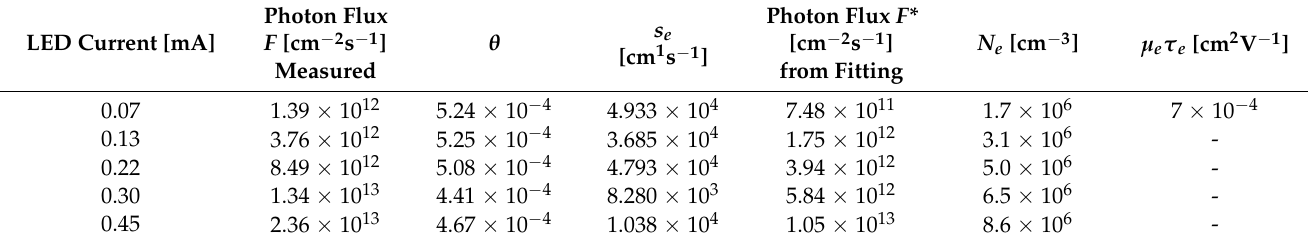
Figure 9. Current density J as a function of voltage V obtained for a (Cd,Mn)Te:In sample etched with 20% HCl . PC-V characteristics were measured at different photon fluxes. The excitation en- ergy was equal to ħω = 1.651 eV = E g + 76 meV. For the lowest photon flux, F = 1.39 × 10 12 cm − 2 s − 1 , the saturation is reached at 150 V. For the highest photon flux, F = 2.36 × 10 13 cm − 2 s − 1 , the saturation is reached at 450 V. Solid lines are fitted to the Ridzonova et al. model.